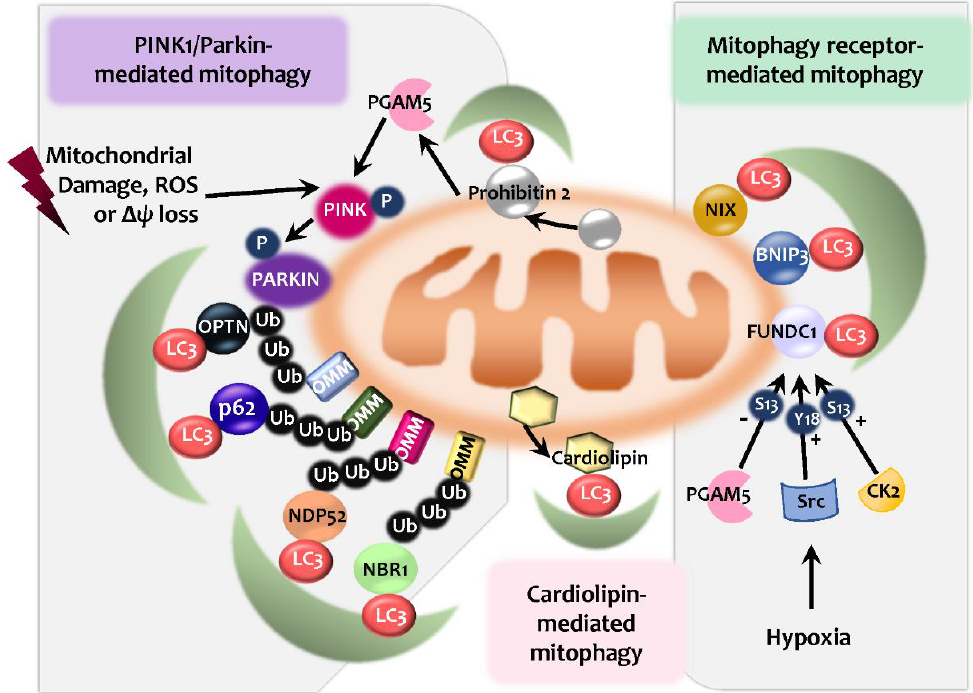
Figure 2. An overview of mitophagy. PINK1 / Parkin-mediated mitophagy involves the recognization of dysfunctional mitochondria by PINK1 and activation of Parkin. This leads to ubiquitination of outer mitochondrial membrane-associated proteins, which are then recognized by autophagic receptors such as p62, OPTN, NDP52, and NBR1. These receptors can bridge the cargos with LC3 / GABARAP to activate selective autophagy. Inner mitochondrial membrane protein Prohibitin 2 promotes PINK1 / Parkin-mediated mitophagy through PGAM5. Mitophagy receptors such as NIX, BNIP3, FUNDC1 present in OMM can interact with LC3 to activate the selective autophagy. FUNDC1 mediates the mitophagy via its dephosphorylation (represented as ‘-’) at Ser-13 by PGAM5 and phosphorylation (represented as ‘ + ’) at Ser-13 and Tyr-18 by CK2 and Src kinase respectively. Cardiolipin, by its transmembrane distribution, can activate mitophagy through binding to LC3 or GABARAP. OPTN, optineurin; OMM, outer mitochondrial membrane-associated proteins; GABARAP, γ -aminobutyric acid A receptor-associated protein; PGAM5, PGAM family member 5; CK2, Casein kinase 2; ∆ ψ , mitochondrial membrane potential; ROS, reactive oxygen species; NIX, NIP3-like protein X; FUNDC1, FUN14 domain containing